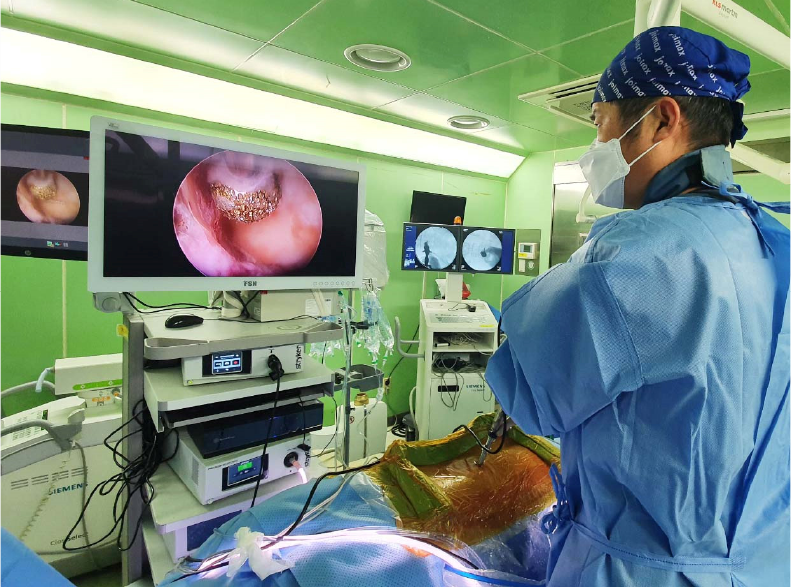
Figure 1. Intraoperative picture shows the set up for lumbar endoscopic unilateral laminotomy with bilateral decompression (LE-ULBD). The patient lies in a prone position with the operating surgeon standing on the same side as the lesion of the lumbar segment. The endoscopic monitor tower is placed directly opposite the surgeon with fluoroscopic equipment adjacent to the endoscopic monitor tower.